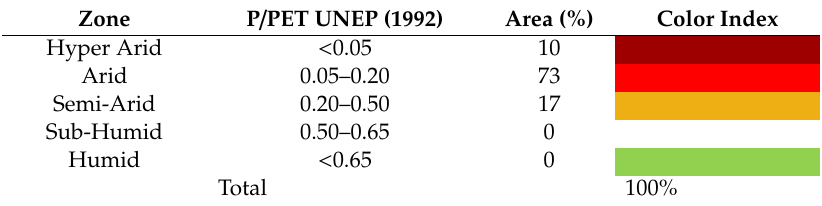
Table 5. The classification of the area based on the aridity severity by using the UNEP method (1992).